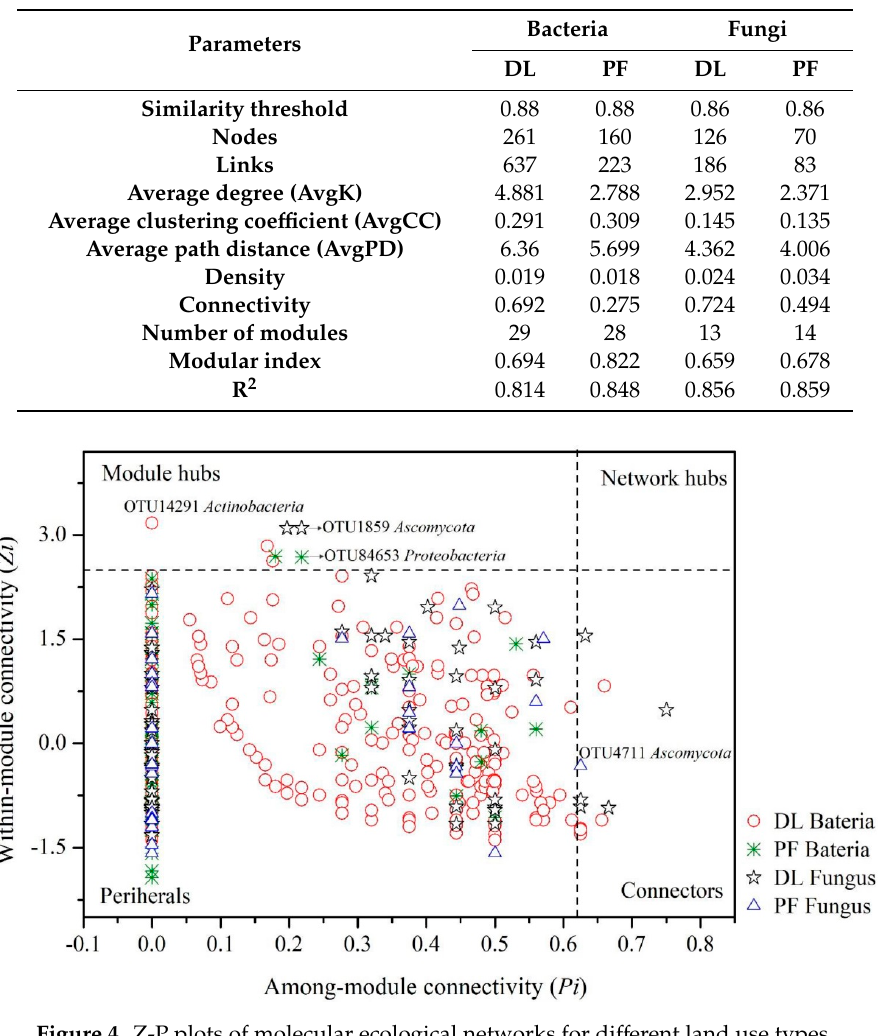
Figure 4. Z-P plots of molecular ecological networks for different land use types.